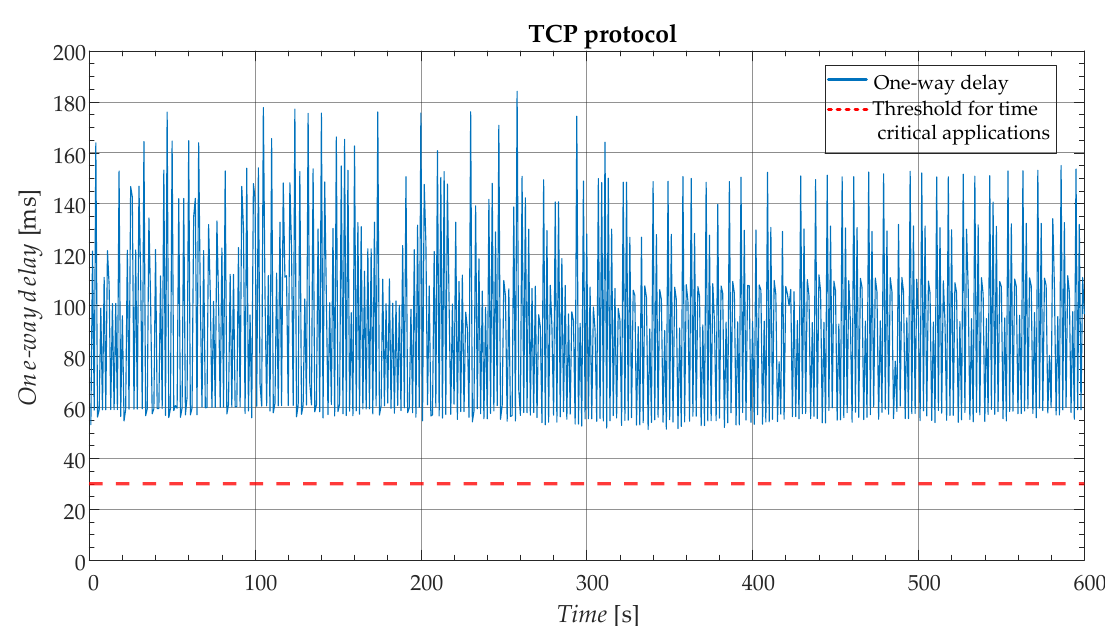
Figure 3. One-way delay for the transmission control protocol (TCP) protocol.